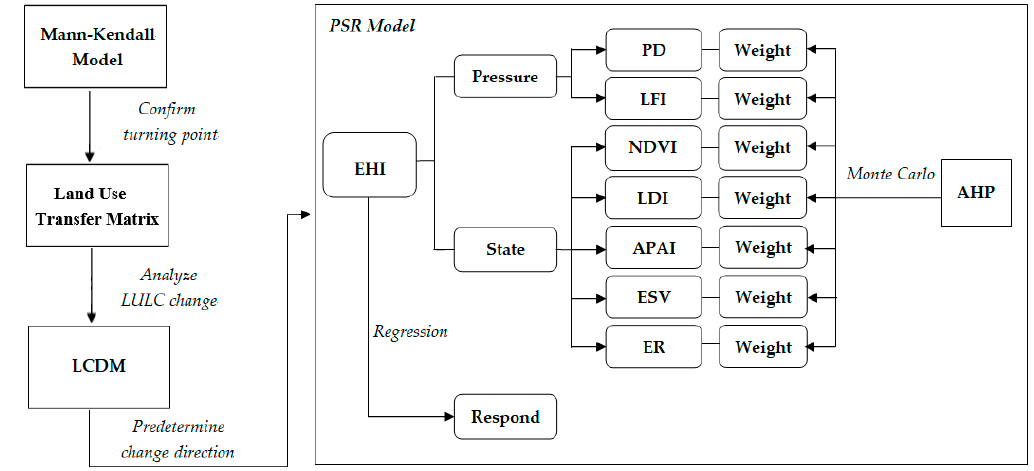
Figure 4. Systematic overview of the methods.